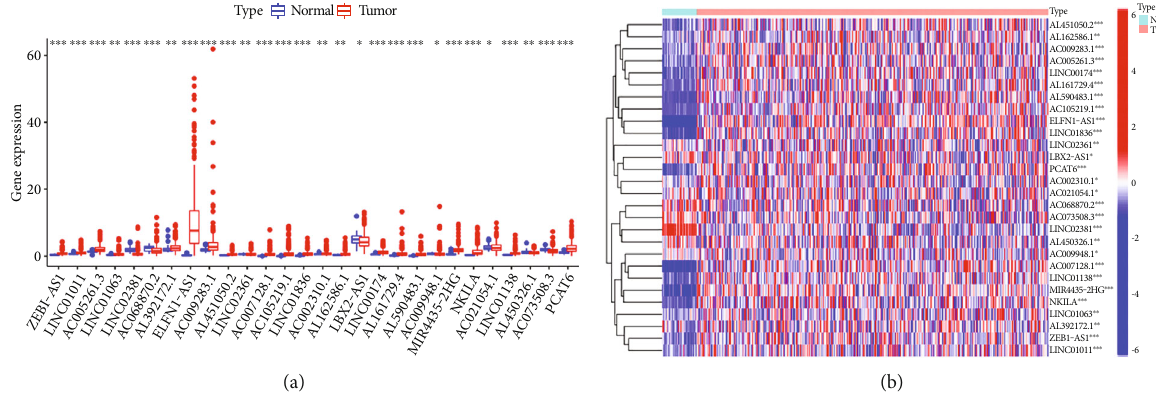
Figure 1: Di ff erential expression of ferroptosis-related lncRNAs in colon cancer and adjacent normal tissues. (a) Boxplot. (b) Heatmap. ∗ p < 0 : 05 , ∗∗ p < 0 : 01 , and ∗∗∗ p < 0 : 001 . The univariate Cox regression analysis results showed that 28 ferroptosis-related lncRNAs correlated with overall survival (OS) of colon cancer patients from TCGA